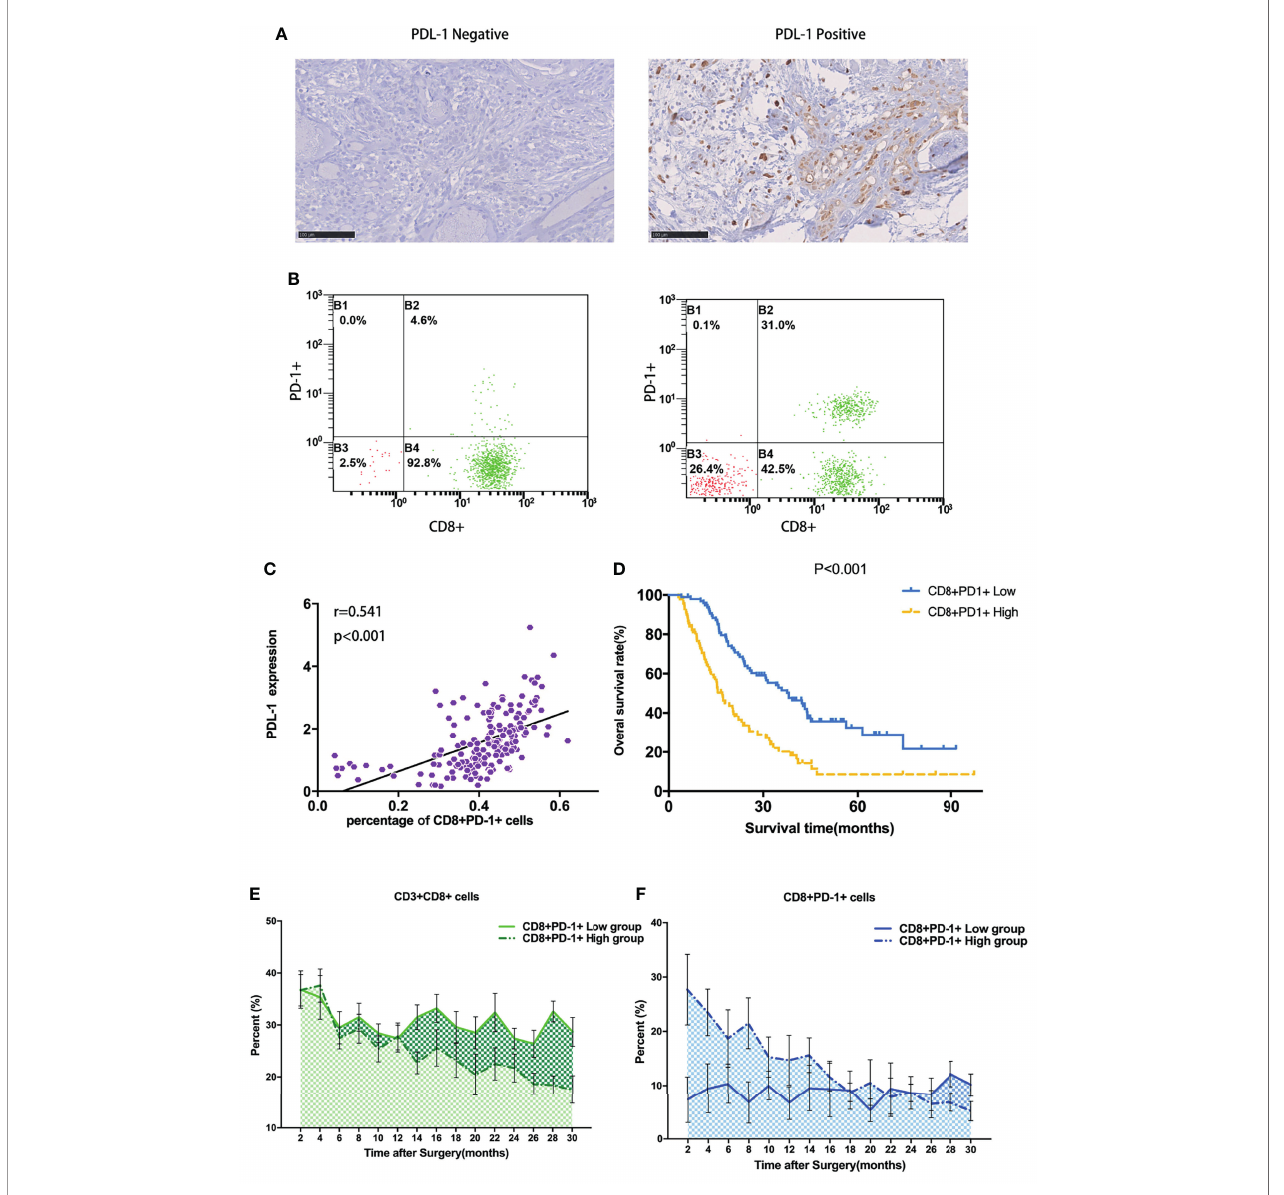
FIGURE 1 | Peripheral CD8 + PD-1 + T cells were related to expression of PD-L1 and the prognosis of patients with PDAC who received surgical resection. (A) High expression vs. low expression level of PD-L1 in PDAC. (B) The peripheral blood T lymphocyte subtype detection and low peripheral CD8 + PD-1 + T cells vs. high CD8 + PD-1 + T cells detected by fl ow cytometry. (C) The percentage of peripheral CD8 + PD-1 + T cells was signi fi cantly correlated with the PD-L1 expression in tumor tissues. (D) The high CD8 + PD-1 + T cells were signi fi cantly associated with short overall survival. (E, F) Tracking test of peripheral blood T lymphocyte subtypes for CD3 + CD8 + T cells and CD8 + PD-1 + T cells for 30 months. PDAC, pancreatic ductal